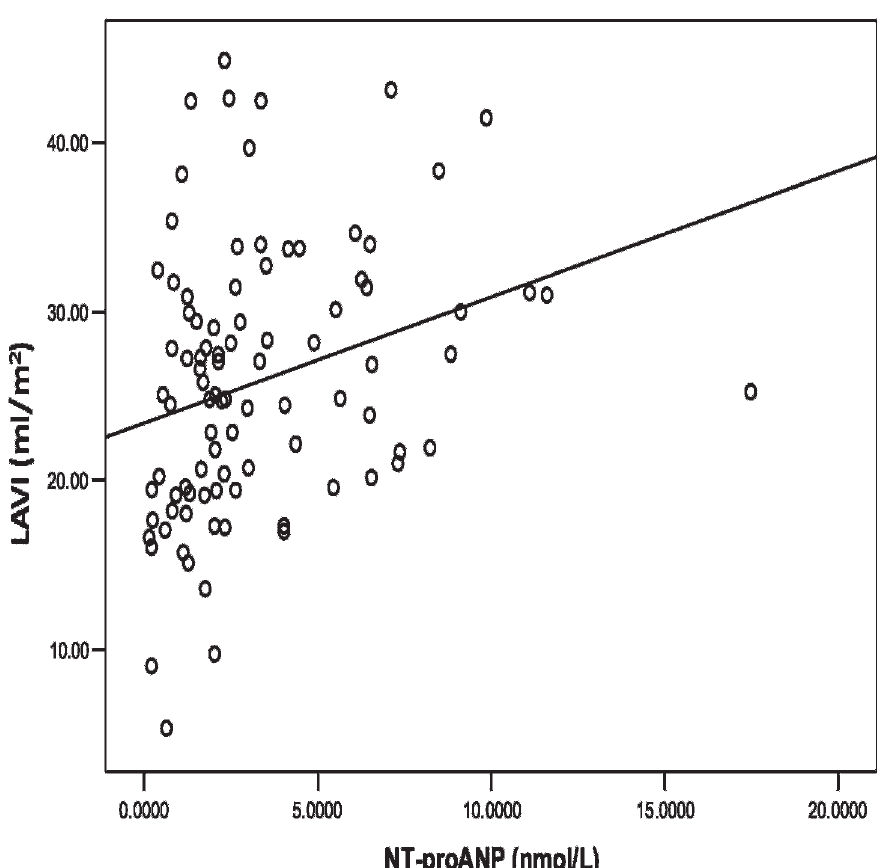
Figure 1 - Scatter plot of the patients’ plasma NT-proANP levels (nmol/L) against the LAVI values (mL/m 2 ) (r=0.28, p